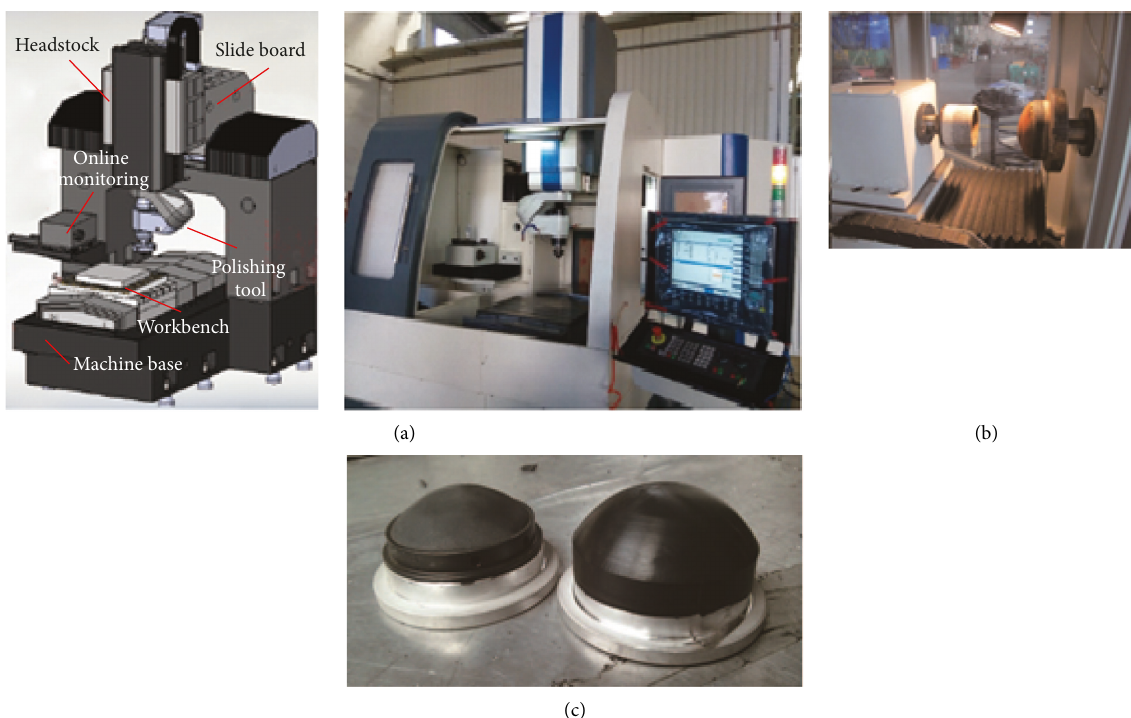
Figure 5: Research on bonnet polishing at Xiamen University [25]. (a) Illustration of bonnet polishing machine and the prototype. (b) Bonnet polishing head. (c) Off-line dressing equipment of bonnet polishing head.